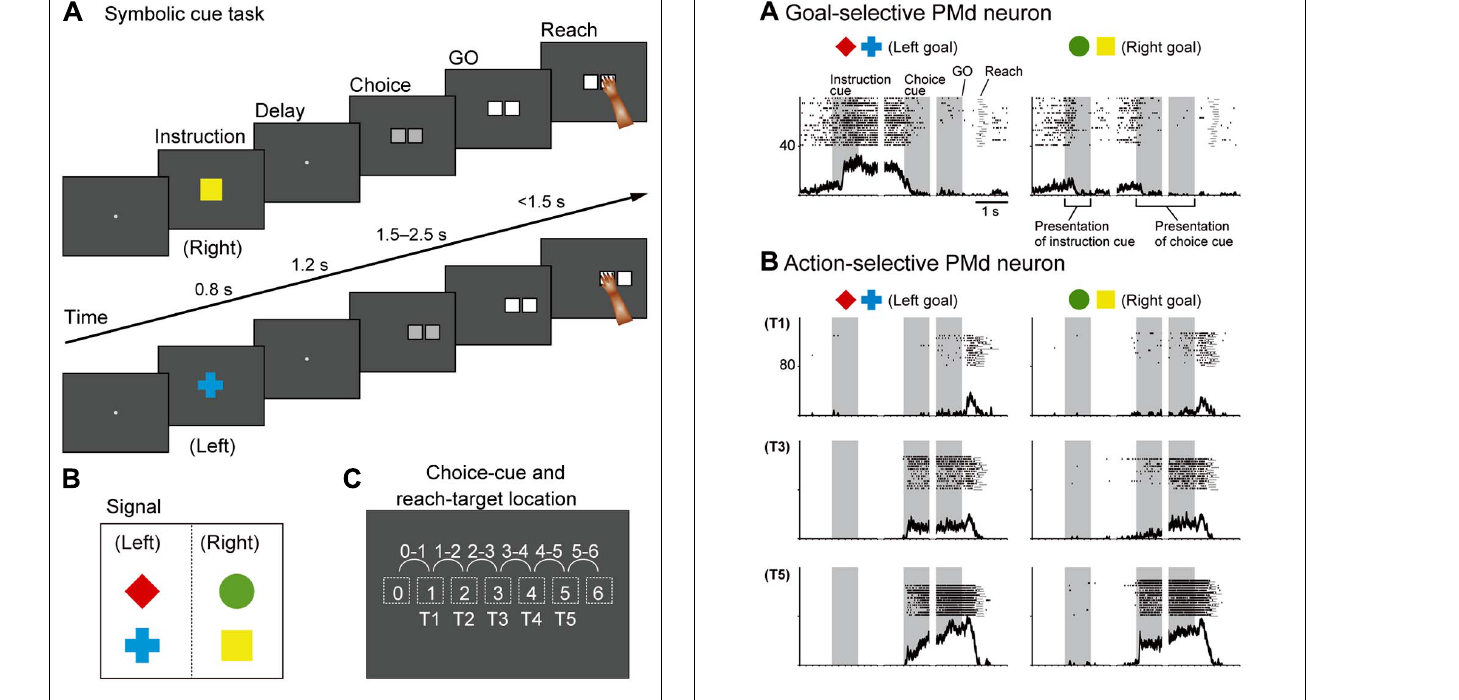
FIGURE 7 |Two examples of neurons in the PMd. (A) Goal-related activity of a PMd neuron. Activity of this PMd neuron increased when either a red diamond or a blue cross was used to specify the left target. (B) Action-related activity of a PMd neuron. After choice-cue onset, this PMd neuron exhibited more activity when the correct target was located on the right side of the screen (T5), regardless of the goal. Of the five positions (T1–T5), only three (T1,T3, andT5) are displayed here. (A,B) Rasters and spike-density functions (smoothed using a Gaussian kernel; σ = 10 ms, mean ± SEM) indicate activity in sorted trials.The ordinate represents the instantaneous firing rate (spikes/s). Neuronal activity was aligned with the onset of the instruction, choice-cue, and GO signals. Gray areas on the left indicate when the instruction was presented, and gray areas in the middle and on the right represent when the choice cue was presented.Tick marks on the horizontal axis are placed at 200-ms intervals (adapted from Nakayama etal.,